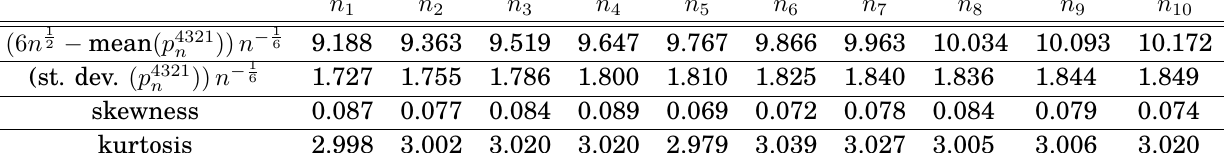
Table 2: Monte Carlo simulation results for three-aligned segments for 10 logarithmically spaced n values from 10 4 to 10 7 . the nearest particle u k − 1 (if any) to the right of u k − 1 r